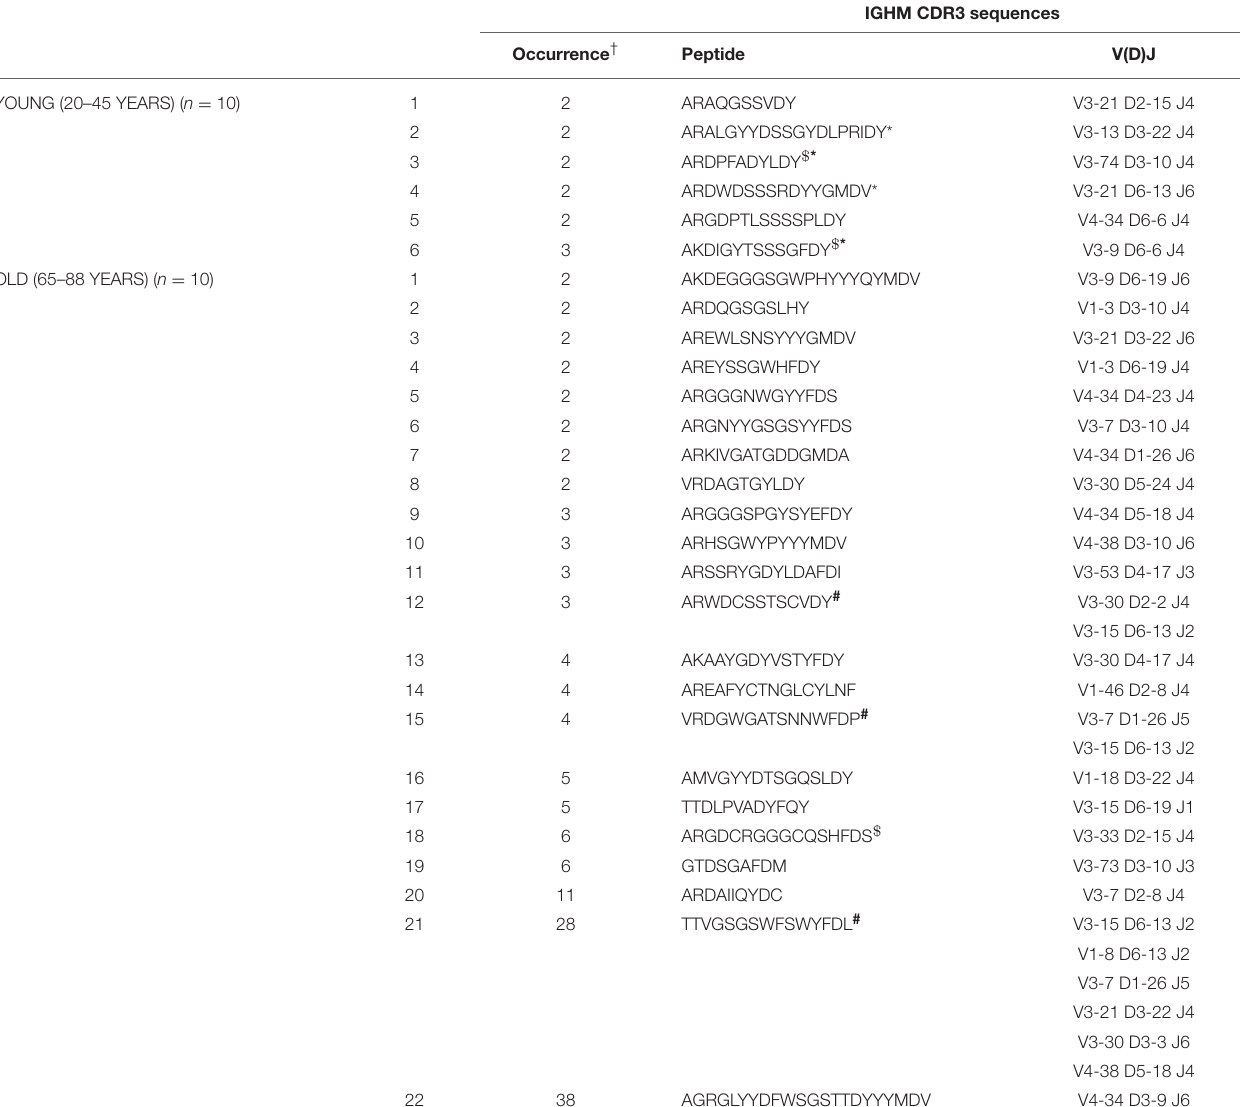
TABLE 2 | Recurring CDR-H3 sequences (peptide and V(D)J recombination) in B-1 cells from young and old